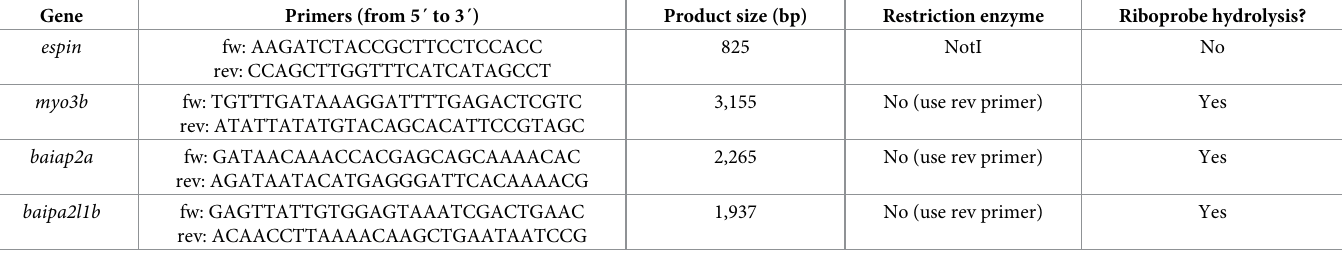
Table 3. Primers and restriction enzymes used to generate the FISH probes in this